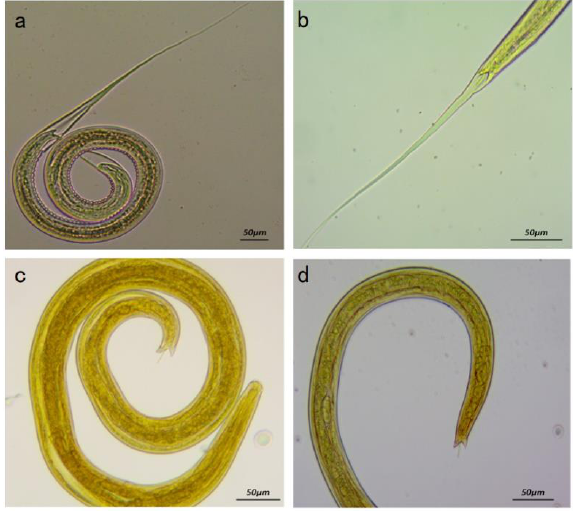
Figure 4. Morphology of L3 of Nematodirus. spp. ( a ) L3 larva (100×). ( b ) Tail of L3 larva (100×). ( c ) Exsheathed L3 larva (250×). ( d ) Tail of exsheathed L3 larva (250×).